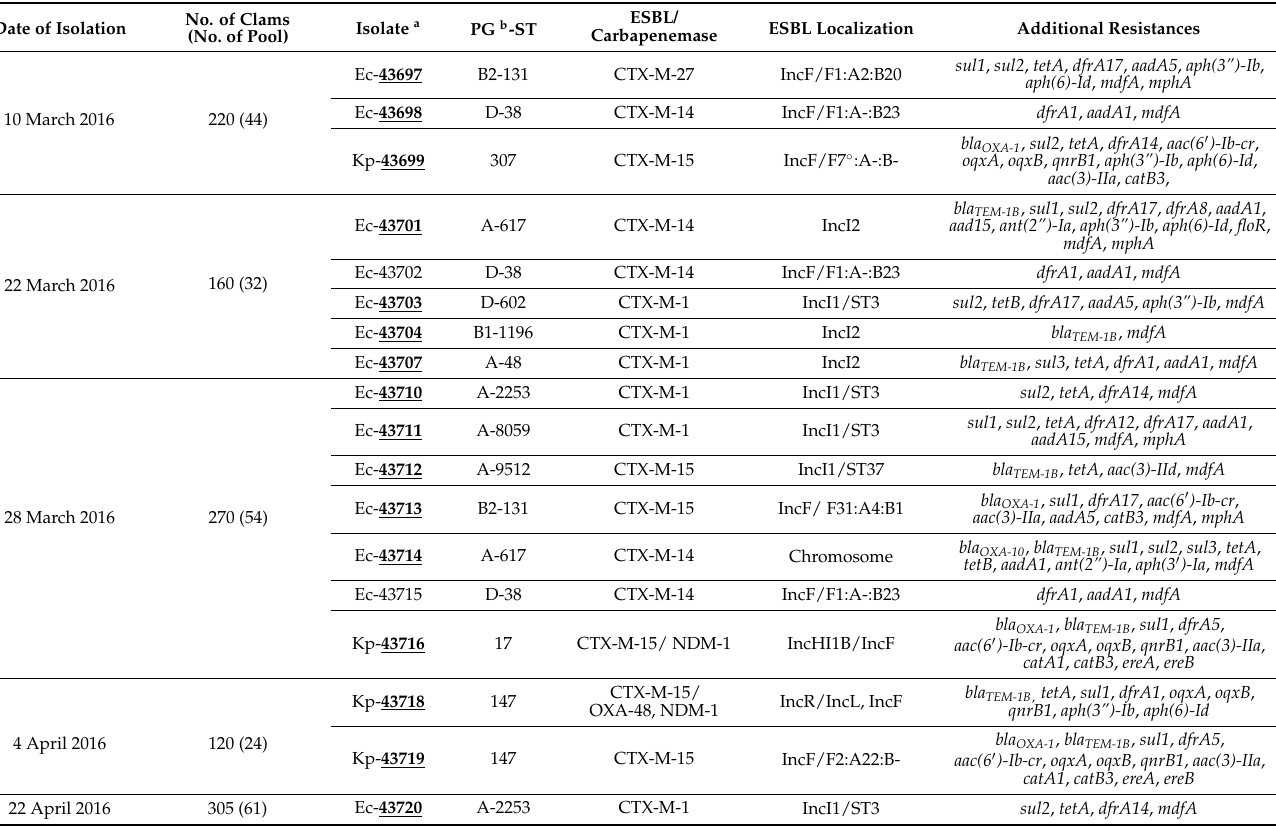
Table 2. Characteristics of isolates collected from